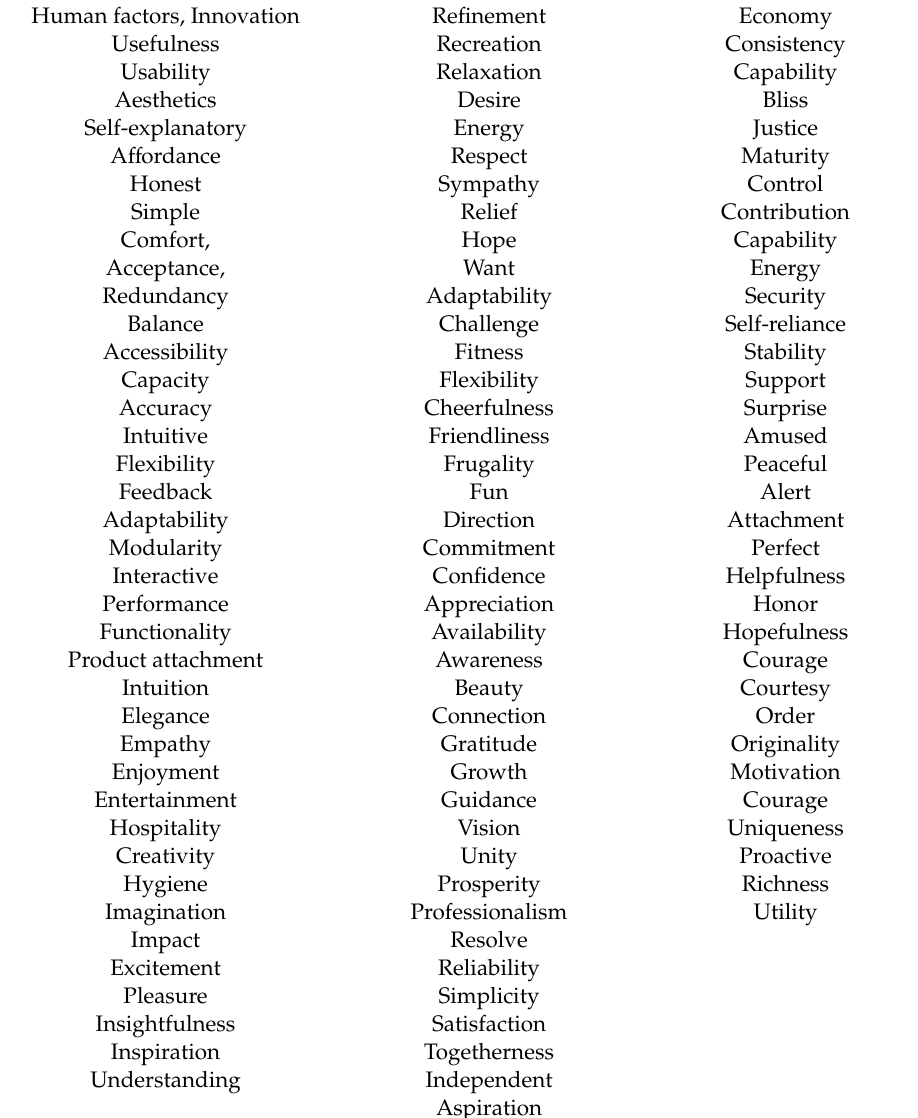
Table A1. List of